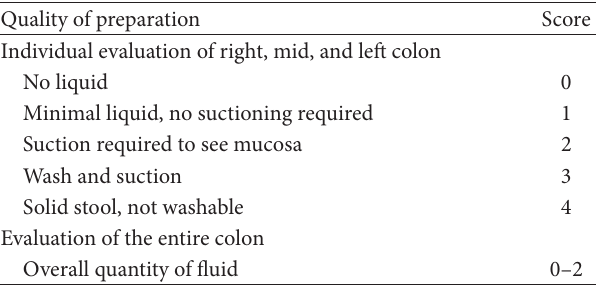
Table 1: Ottawa Bowel Preparation Quality